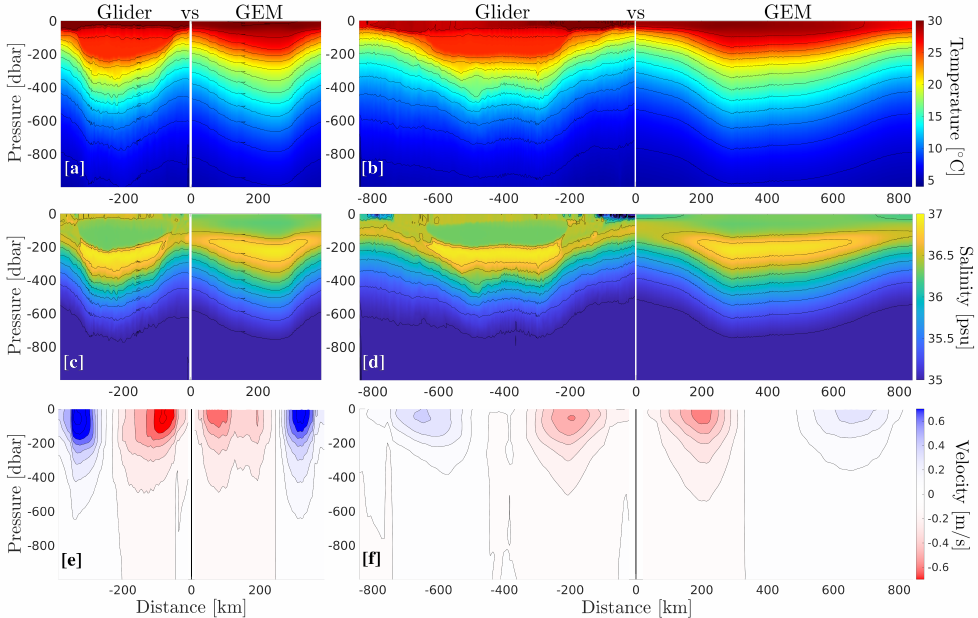
Figure 6. ( a , b ): Temperature sections across a Loop Current ring measured by the glider and reconstructed using the GEM. in each panel, the GEM-reconstructed sections are flipped laterally in order to appear as a mirror image of the glider section. ( c , d ): Same as ( a , b ) for salinity. ( e , f ): Same as ( a , b ) for geostrophic